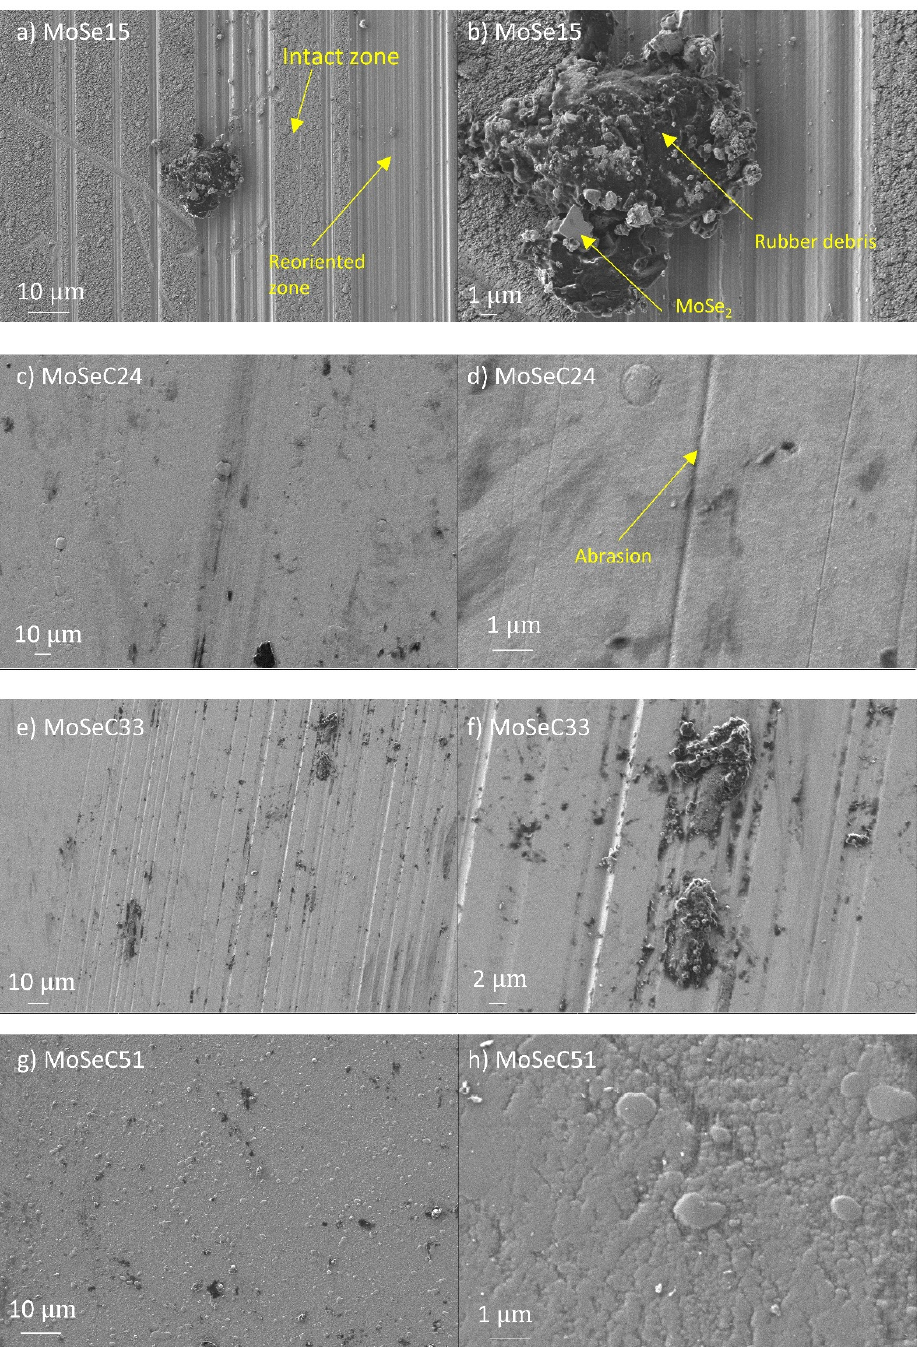
Figure 10. Micrographs of the wear tracks for the Mo-Se-C coatings after POD experiments against rubber at 25 °C: ( a ) MoSe at lower magnification (LM) imaging; ( b ) detailed features of the MoSe at high magnification (HM) imaging; ( c ) MoSeC24 at LM imaging; ( d ) detailed features of the MoSeC24 at HM imaging; ( e ) MoSeC33 at LM imaging; ( f ) MoSeC33 at HM imaging; ( g ) MoSeC51 at LM imaging; and ( h ) MoSeC51 at HM imaging.